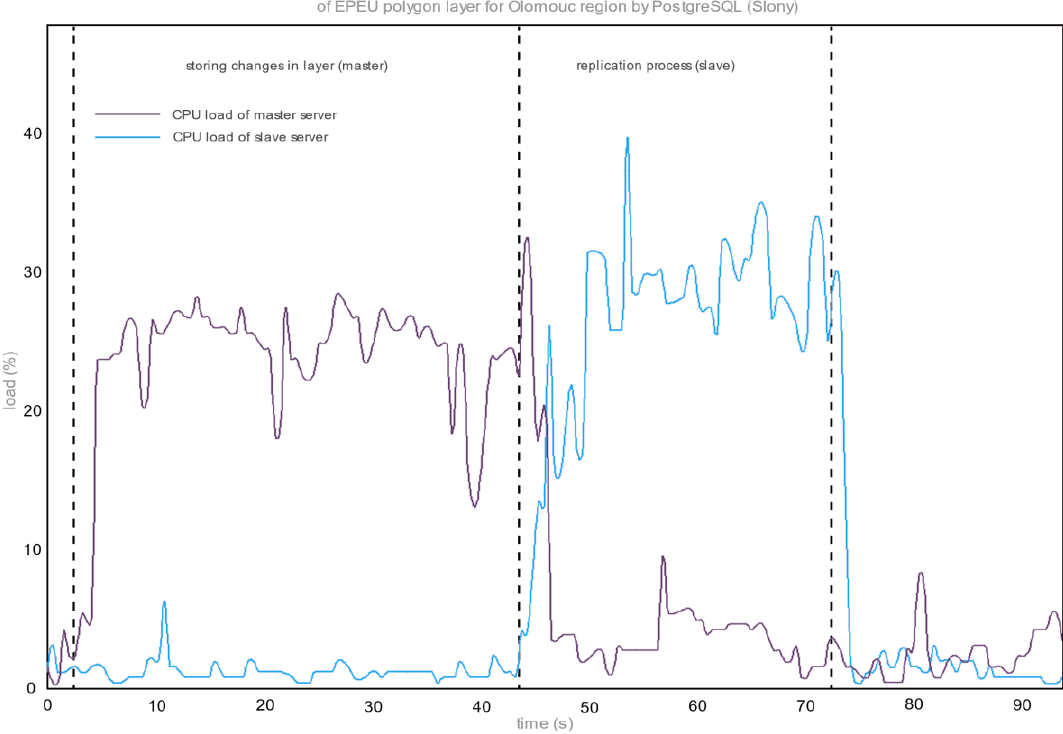
Figure 1. Average Central Processing Unit (CPU) load during replication of the estimated pedologic-ecological unit (EPEU) layer by PostgreSQL (Slony).